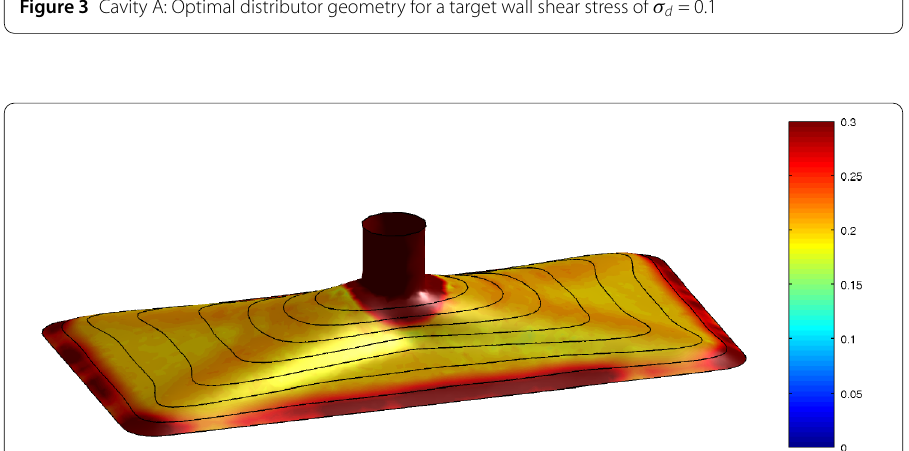
Figure 4 Cavity B: Optimal distributor geometry for a target wall shear stress of σ d =